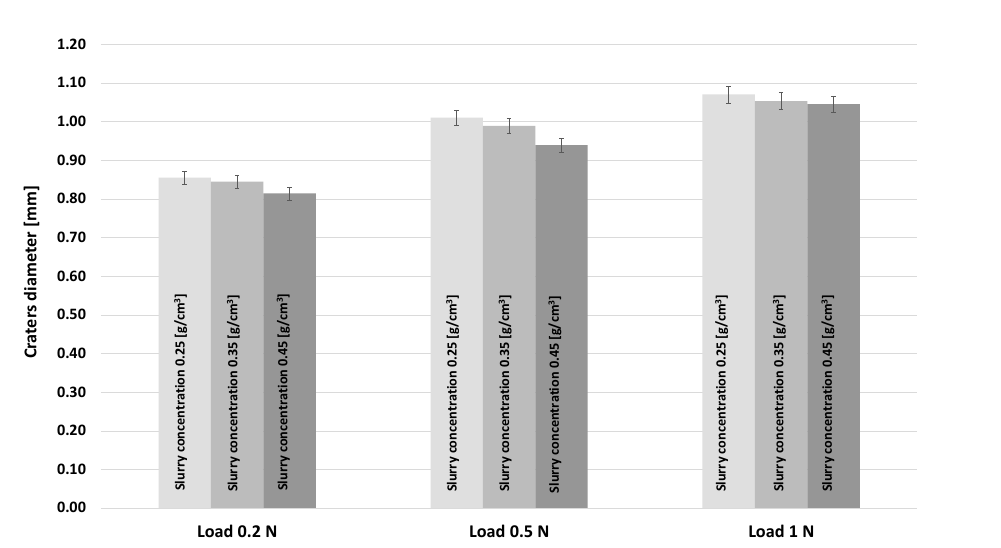
Figure 12. Roughness parameter trends (Sa) for different abrasive mass loads such as 0.2 N, 0.5 N and 1N.